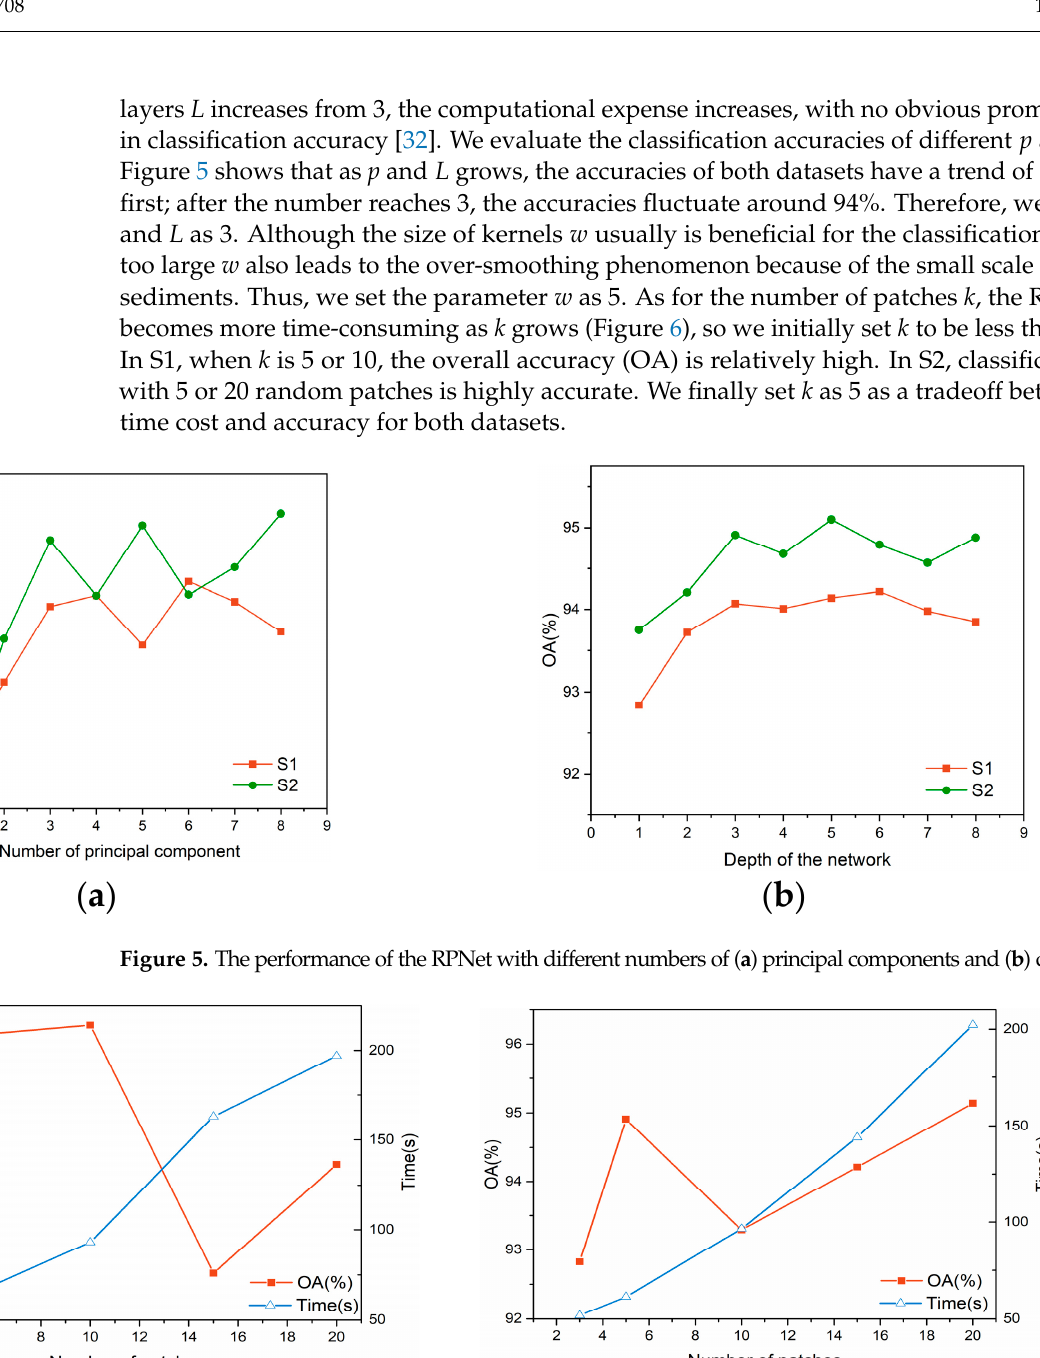
( c ) Figure 7. Feature extraction results for each layer in S1. ( a – c ) show results from the first to the third layer. ( a ) ( b ) ( c ) Figure 8. Feature extraction results for each layer in S2. ( a – c ) show results from the first to the third layer.